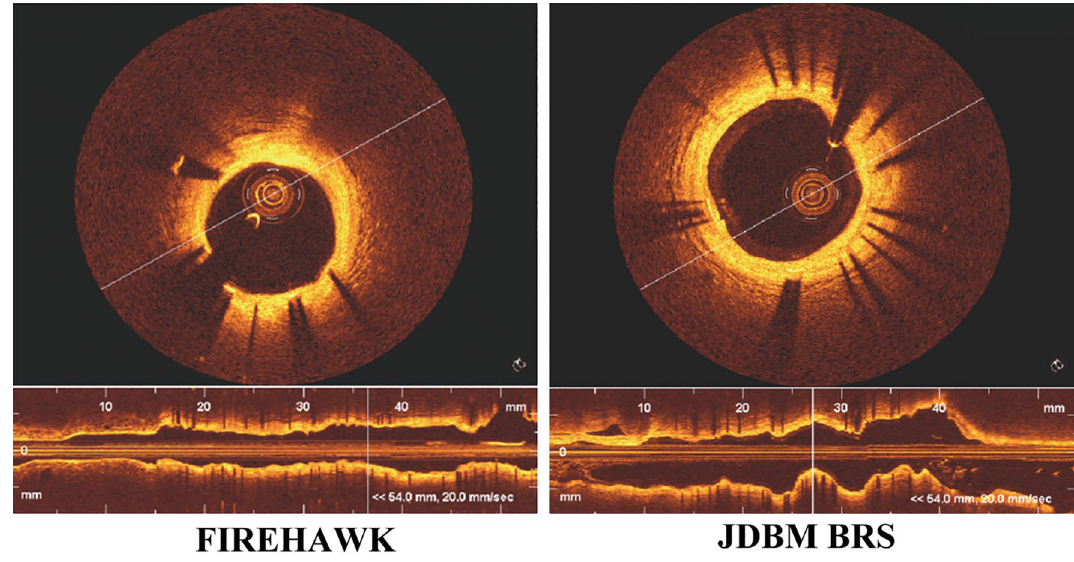
Figure 4. Representative OCT images of JDBM BRS and FIREHAWK stent in the porcine coronary artery at day 180 after stent implantation.